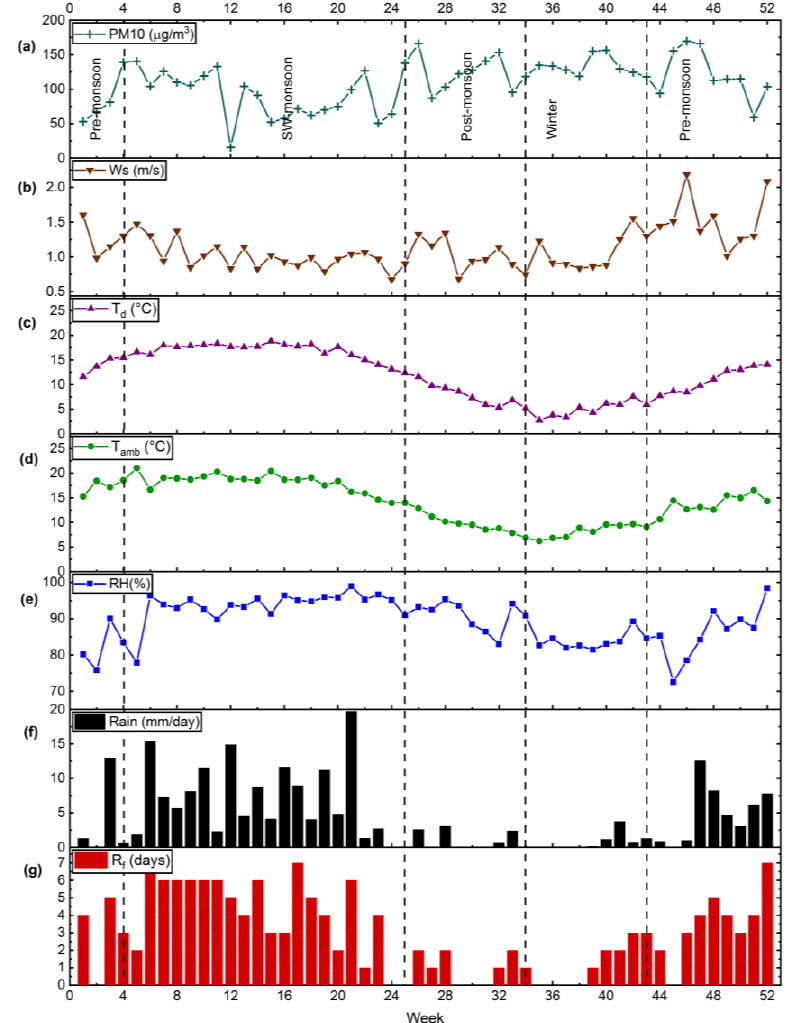
Figure 2. The average weekly value of the environmental parameters ( a ) particulate matter, PM10 (µg/m 3 ); ( b ) wind speed, Ws (m/s); ( c ) dew point temperature, T d (°C); ( d ) ambient air temperature, T amb (°C); ( e ) relative humidity, RH (%); ( f ) rainfall intensity, Rain (mm/day), which is equal to the direct average, over a given week, of the rainfall recorded in mm per minute multiplied by 60 min × 24 h; and ( g ) weekly frequency of rainfall R f (days).